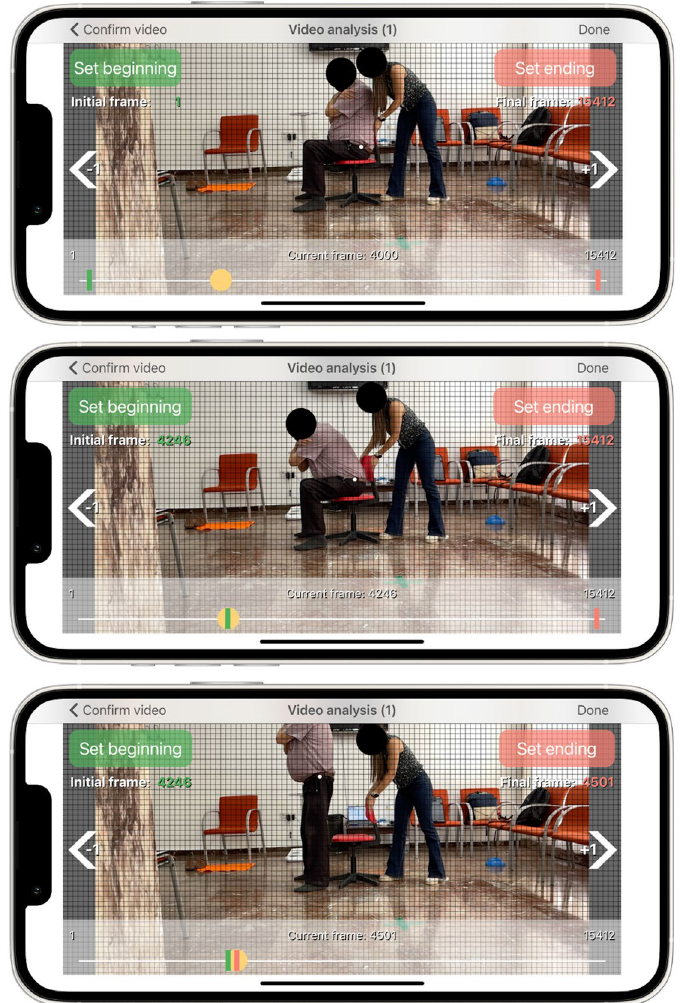
Figure 1. User interface of the App. White dot represents the reflective marker placed on the greater trochanter while the subject is in a sitting position ( top panel ), at the beginning of the vertical movement when the reflective marker crosses the first horizontal grip line on the screen ( middle panel ), and at the end of the vertical movement, when the reflective marker achieves the highest point ( lower panel ).